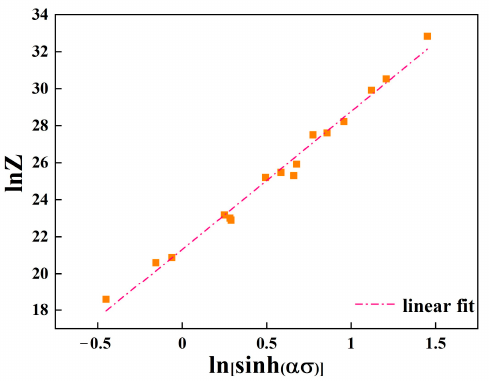
Figure 6. Relationship between peak stress and Zener − Hollomon parameter.